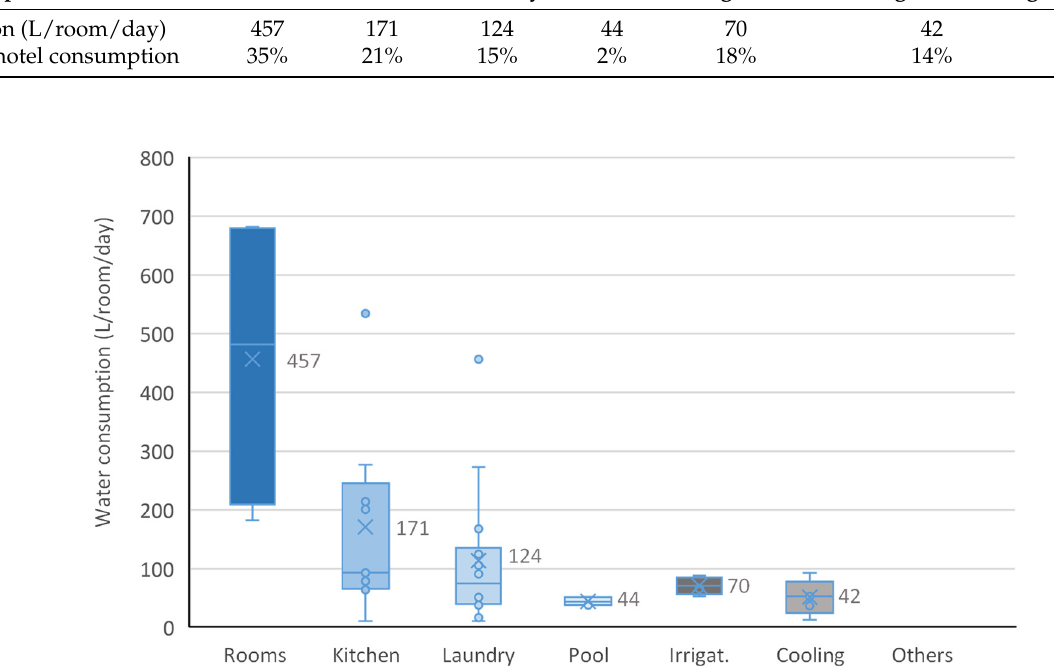
Figure 1. Box-whisker graphs for water consumption per floor area, room, and guest.